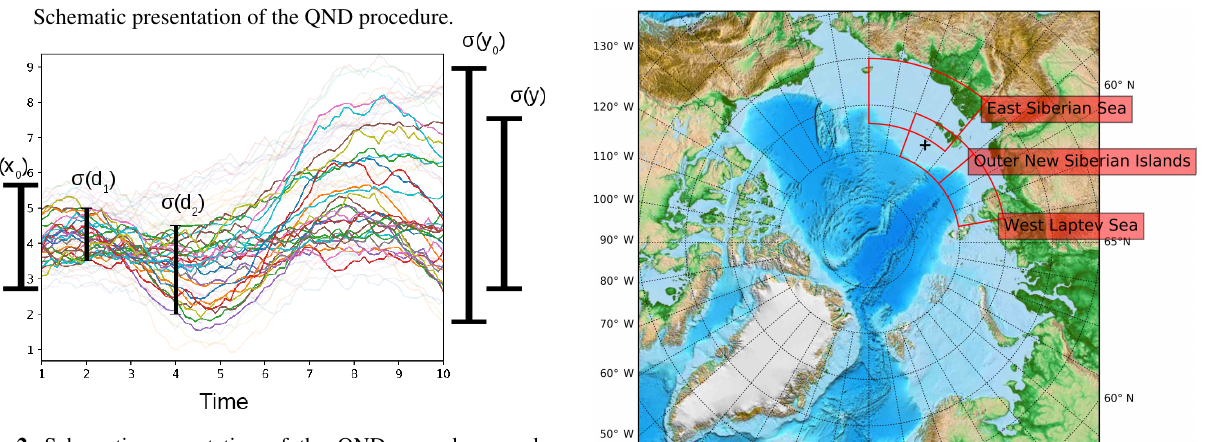
Figure 2. Schematic presentation of the QND procedure: each coloured line illustrates a model trajectory that simulates counter- parts of the observations ( d 1 and d 2 ) and a target quantity ( y ) for a given value of the control vector ( x ). Through the model, the ob- servations act as constraints on the control vector, which reduces its uncertainty from C ( x 0 ) to C ( x ) . This uncertainty reduction on the control vector translates into an uncertainty reduction in the target quantity from σ(y 0 ) to σ(y) .